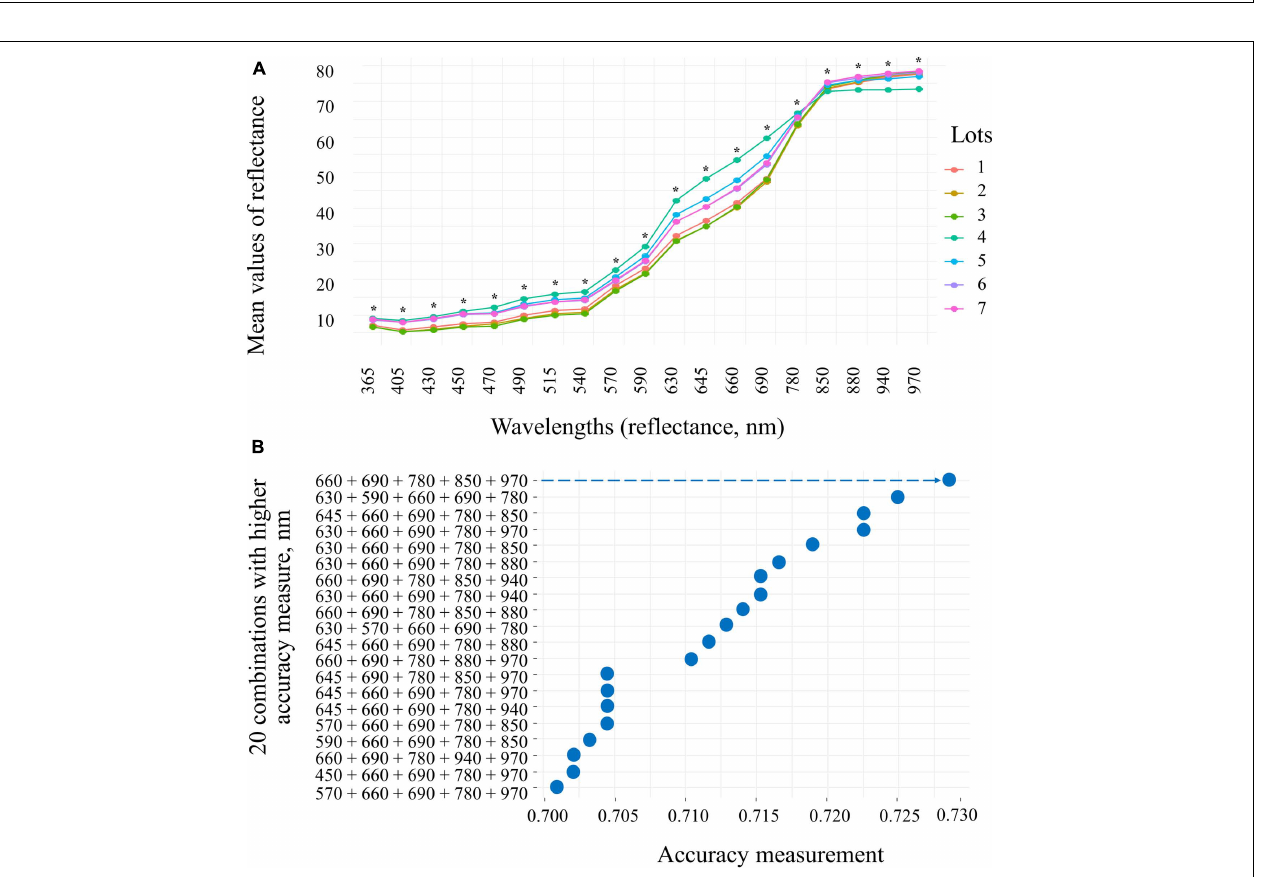
FIGURE 7 | Reflectance spectral signature at 19 wavelengths (365 to 970 nm) of seven peanut seedlots ( Arachis hypogaea L.; cv. IAC OL3) (A) and 20 combinations of wavelengths with distribution of accuracy determined by interactive process analysis (B) . The arrow indicates the combination of bands (660, 690, 780, 850, and 970) that showed the highest accuracy (0.730) for the subsequent analyses. ∗ significant at the 0.05 probability levels ( n = 170).